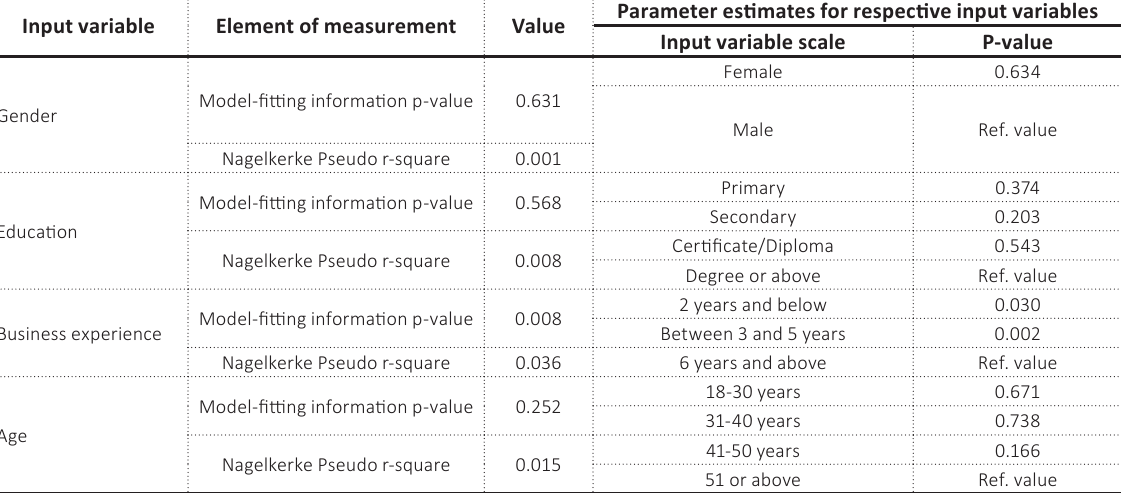
Table 4. Demographic variables and level of compliance – ordinal regression